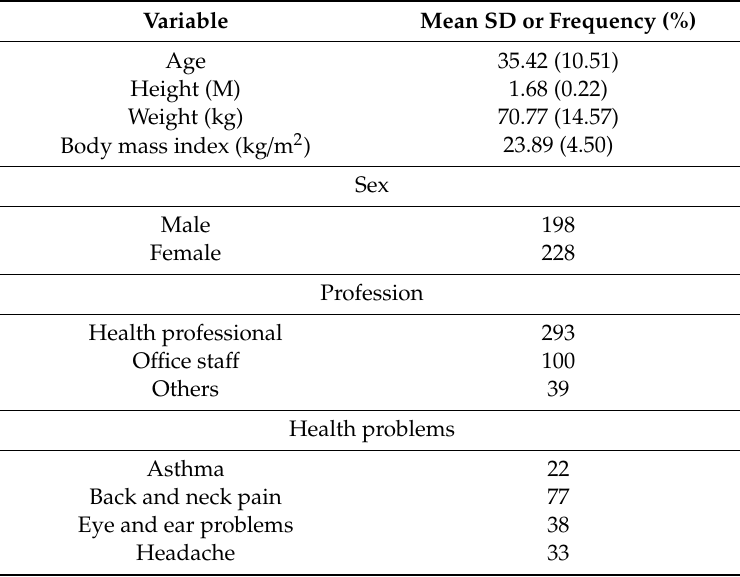
Table 1. Characteristics of the participants ( N =